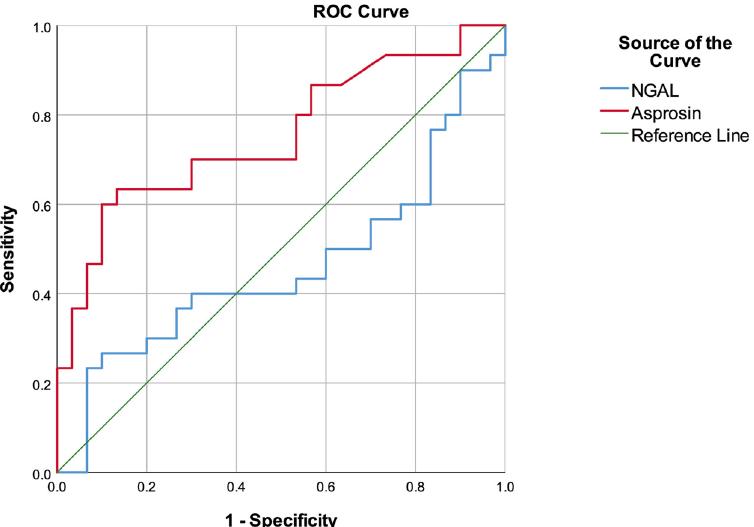
Figure 2: ROC curve of the NGAL and asprosin for ROP diagnosis.